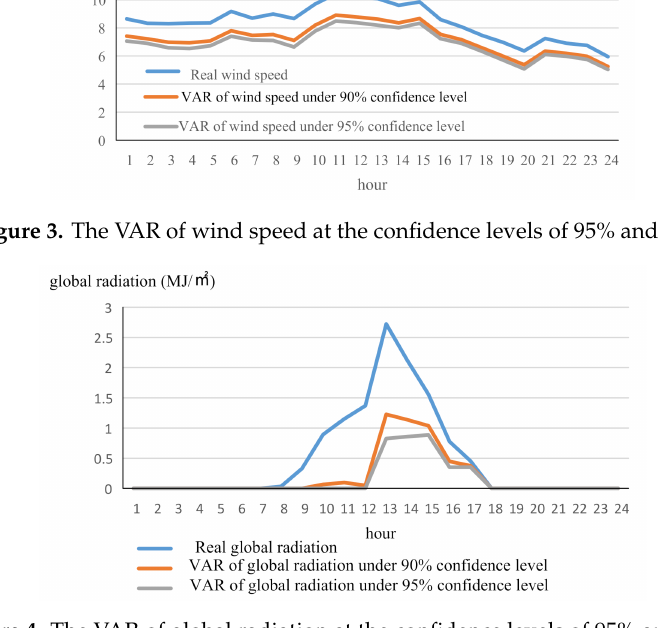
Figure 4. The VAR of global radiation at the confidence levels of 95% and